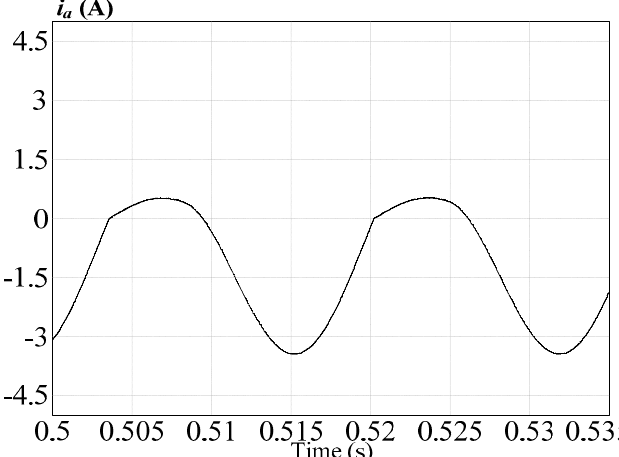
Figure 5. Waveform of line current i a for an inverter working at 60 Hz with faulty switch S a 1+ .